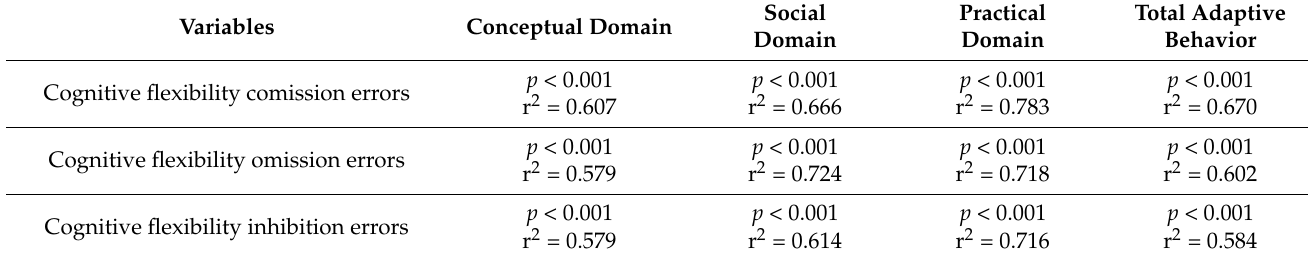
Table 2. Results of interaction between executive functions and adaptive behavior.